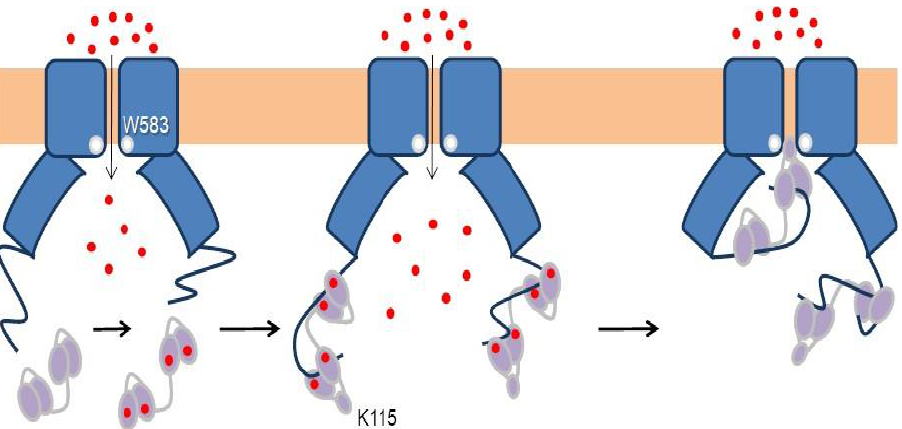
Figure 11. Ball and chain-like mechanism of TRPV5/6 channel inactivation. The influx of Ca 2+ triggers CaM binding to the C-terminal tail. CaM docks within the intracellular dome in a position that favors plugging the pore with Lys 115 located in the middle of the EF3/4 linker. The ensuing decrease on Ca 2+ within the dome should cause the release of CaM, followed by the re-initiation of another cycle. The “chain” is composed of two alpha helices, C1 and C2, where the N- and C-lobes engage, respectively [79–81]. C1 and C2 are separated by a ~40 residue flexible linker, not seen in the cryo- EM images. CaM adopts a stretched pose, where each lobe target is independent of the other. The distance between the main anchoring sites (F651 in C1 and W701 in C2) is ~29 Å . Helix C2 is trapped